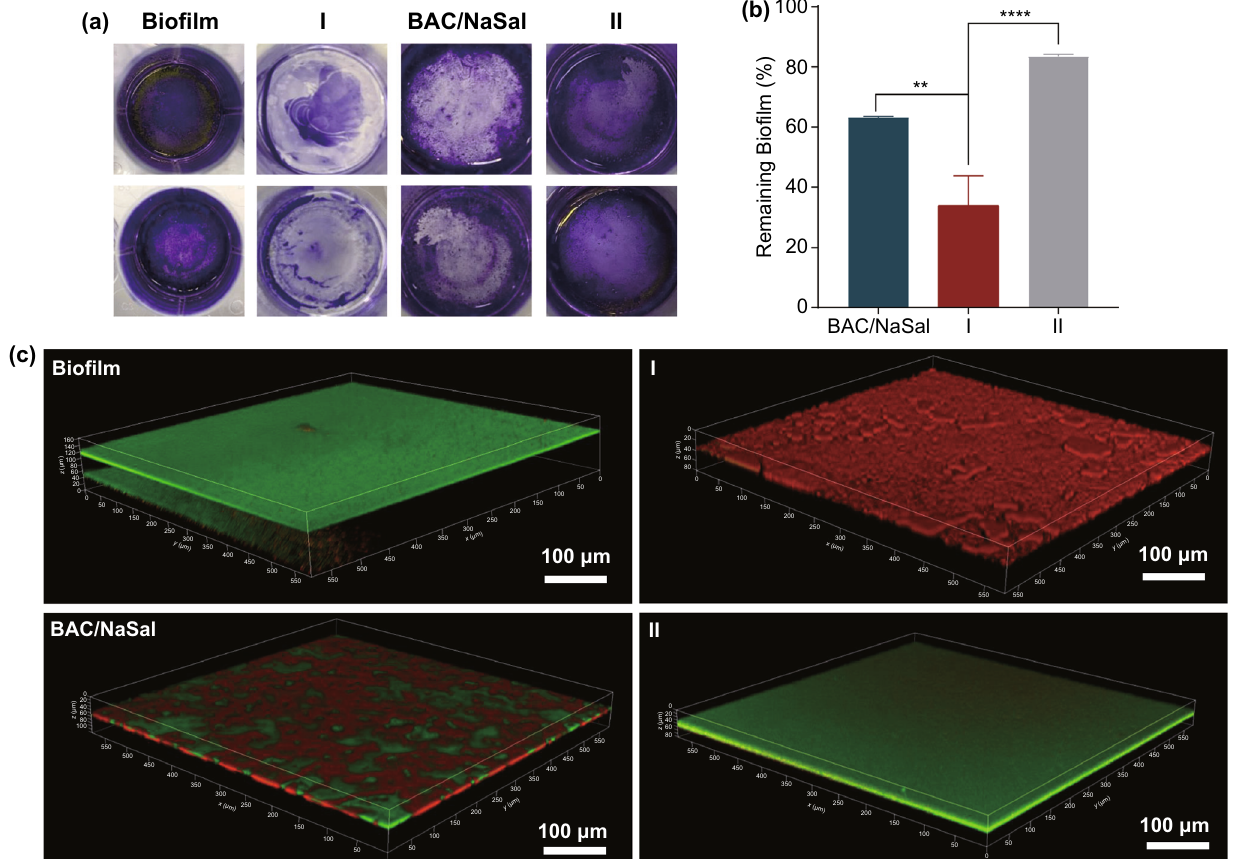
Fig. 3 a Digital images of biofilms stained by CV. b Quantitative analysis of CV stained biofilm. c 3-D Confocal images of 24 h old biofilm treated by PBS, nanocomposite I , BAC/NaSal or nanocomposite